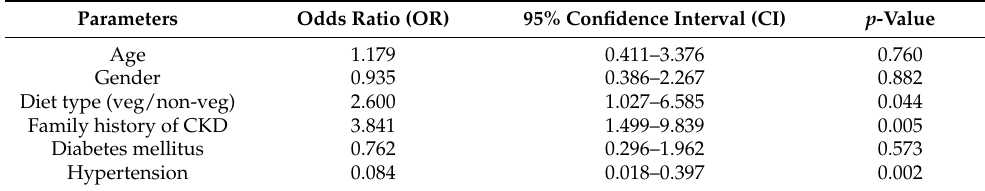
Table 6. Univariable logistic regression analysis to identify the risk factors for CKD progression.